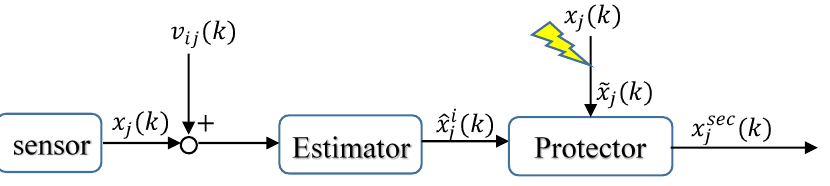
Figure 4. The schematic diagram of the screening mechanism. x j ( k ) represents the state value of agent j obtained by the sensor, and v ij ( k ) is the sensor noise in agent i . ˆ x i agent i , and ˜ x j ( k ) is the state value that may be tampered by the deception attack. Through the screening mechanism of the protector, the system can finally obtain the secure state value x sec